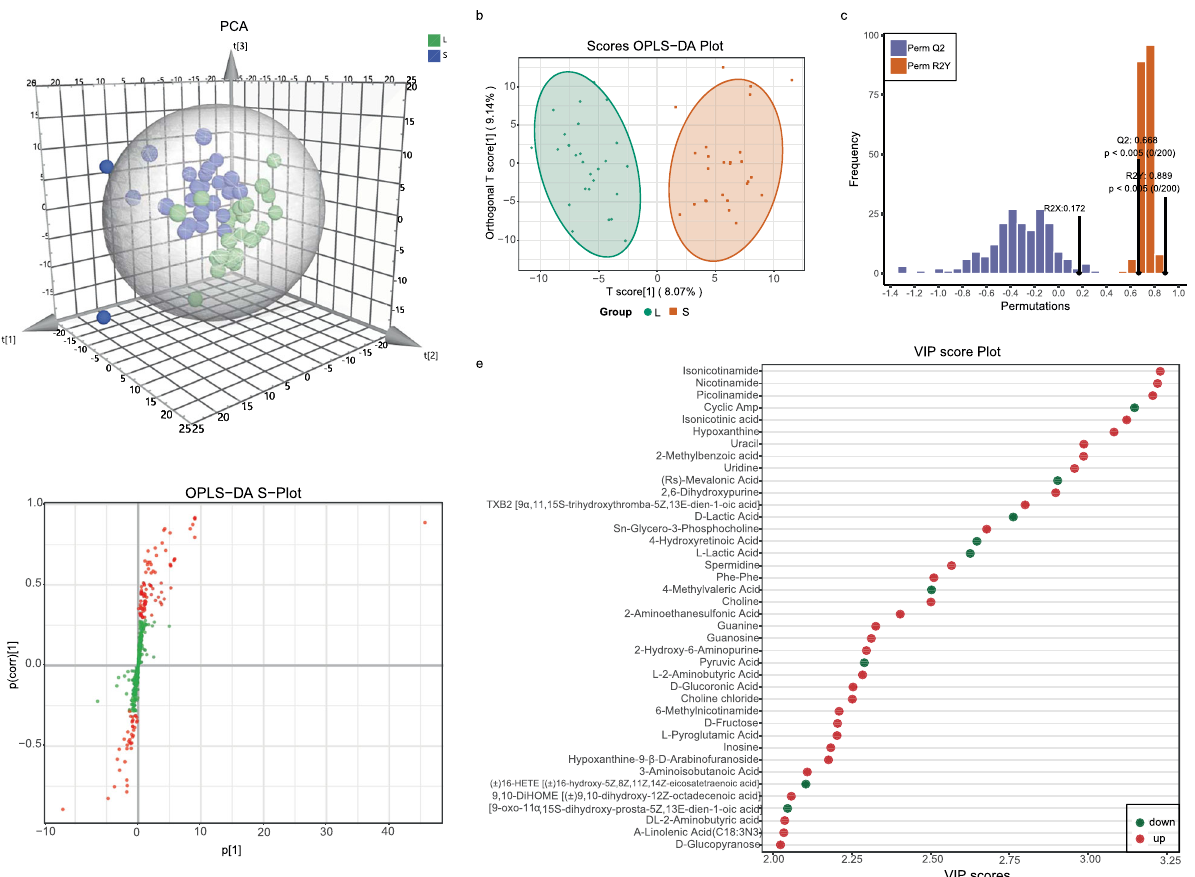
Fig. 2 The overview of metabolomic analysis of the follicular fl uid from human ovarian follicles of different sizes. a PCA showed the effect of separation between the two groups of follicular fl uid samples. b OPLS-DA score plot demonstrating good separation between the two groups, based on the regression model. Samples belonging to the large follicles and small follicles are represented by green and red nodes, respectively. c The OPLS-DA model validation depicts a prediction power (Q2) of 0.668 and a correlation index (R2Y) of 0.889, based on cross-validation. d S-plot of OPLS-DA. Red dot VIP value ≥ 1, green dot represents metabolite VIP value <1. e Alterations in 40 representative differential metabolites with p < 0.03 and VIP ≥ 2. Horizontal axis represents the VIP score (contribution of a given variable to the regression model) of each